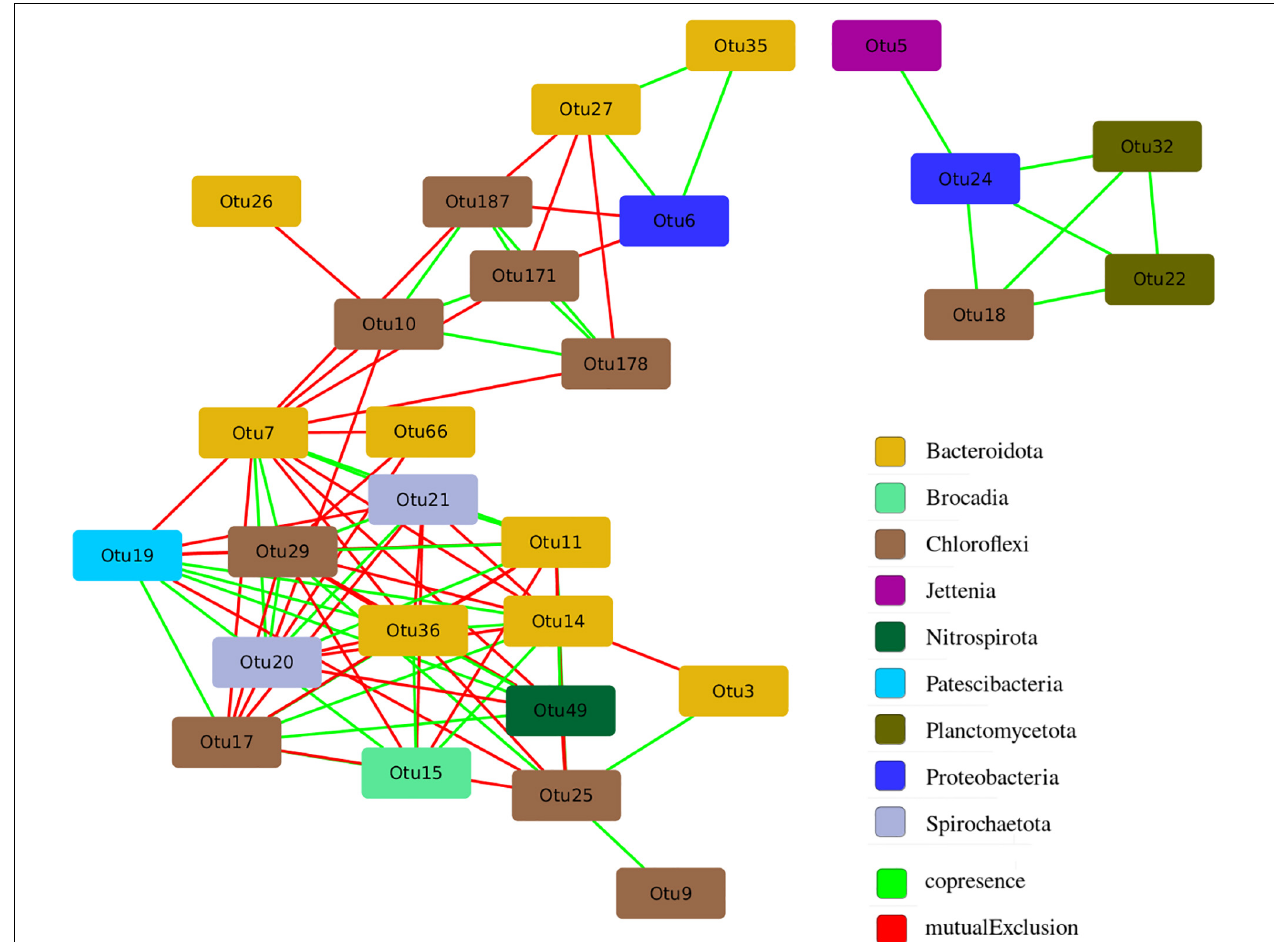
FIGURE 9 | Co-occurrence and mutual exclusion among various microorganisms in the studied anammox community.